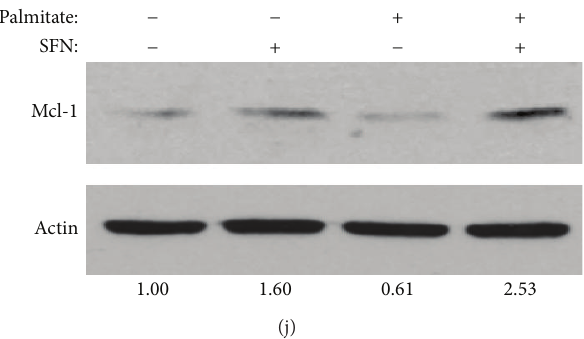
Figure 6: SFN protects 𝛽 -cells from FFA-induced cell death. (a) MIN6 cells were treated with 10 𝜇 M MG132 and 2 mM SFN for 24 h and levels of ubiquitinated proteins were measured by Western blot. The result is representative of two independent experiments. (b) MIN6 cells were treated with SFN and palmitate as indicated and Western blot analysis was conducted to detect ubiquitinated proteins. 𝛽 -actin levels were used as a loading control. The result is representative of two independent experiments. (c) MIN6 cells were treated for 24h as indicated and viability was detected by HO/PI. Results are the means ± SEM of 4 independent experiments. ∗∗ 𝑃 < 0.01 . ((d)–(g)) MIN6 cells were treated with 0.5 mM palmitate and/or 2mM SFN for 24 h and ER stress markers (ATF4, Chop, and Bip) and PUMA measured by qPCR as indicated. Results are the means ± SEM of 3-4 independent experiments. ∗ 𝑃 < 0.05 . ((h)–(j)) MIN6 cells were treated with 0.5 mM palmitate and/or 2 mM SFN for 24 h and expression of prosurvival Bcl-2 proteins was measured by Western blotting with antibodies detecting Bcl-2 (h), Bcl-XL (i), and Mcl-1 (j). Quantification of protein bands is indicated at the bottom as a ratio to 𝛽 -actin loading control. The results are representative of two independent